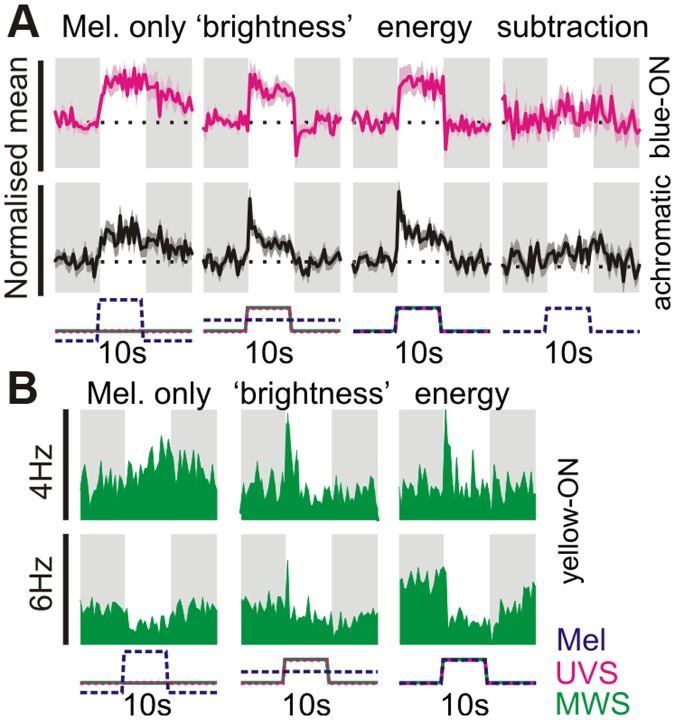
Melanopsin signals influence both colour- and brightness-sensitive cells.(A) Normalised mean (±SEM) response of blue-ON colour-sensitive (n = 13) and achromatic cells (n = 23 tested) to stimuli targeting melanopsin and/or cones. Melanopsin-isolating stimuli presented a 92% Michelson contrast change (~1.4 log units), all other stimuli were 70% Michelson contrast (see S1A Fig for details of “colour” and “brightness” stimuli). The energy condition reflects a spectrally neutral modulation in light intensity, providing 70% Michelson contrast for all retinal opsins. Far right panels reflect the predicted melanopsin contribution to the 70% energy condition (obtained by subtracting the responses to UVS + LWS only −”brightness”). Responses were normalised on a within-cell basis across all three stimulus conditions and are plotted on the same scale to highlight relative response amplitude. X-axis scale bars indicate temporal profile of UVS/LWS opsin and melanopsin excitation. (B) Example responses of yellow-ON colour-sensitive cells (bottom panels) to stimuli targeting melanopsin and/or cones or melanopsin. Melanopsin-isolating contrast had more heterogeneous effects in yellow-ON cells, with 1/4 cells exhibiting a reduction in firing and 2 cells displaying no obvious response (not shown). Conventions as above except that data are presented as raw firing rates. Y-axis scale bars represent peak firing in spikes/s. The data used to make this figure can be found in S3 Data.